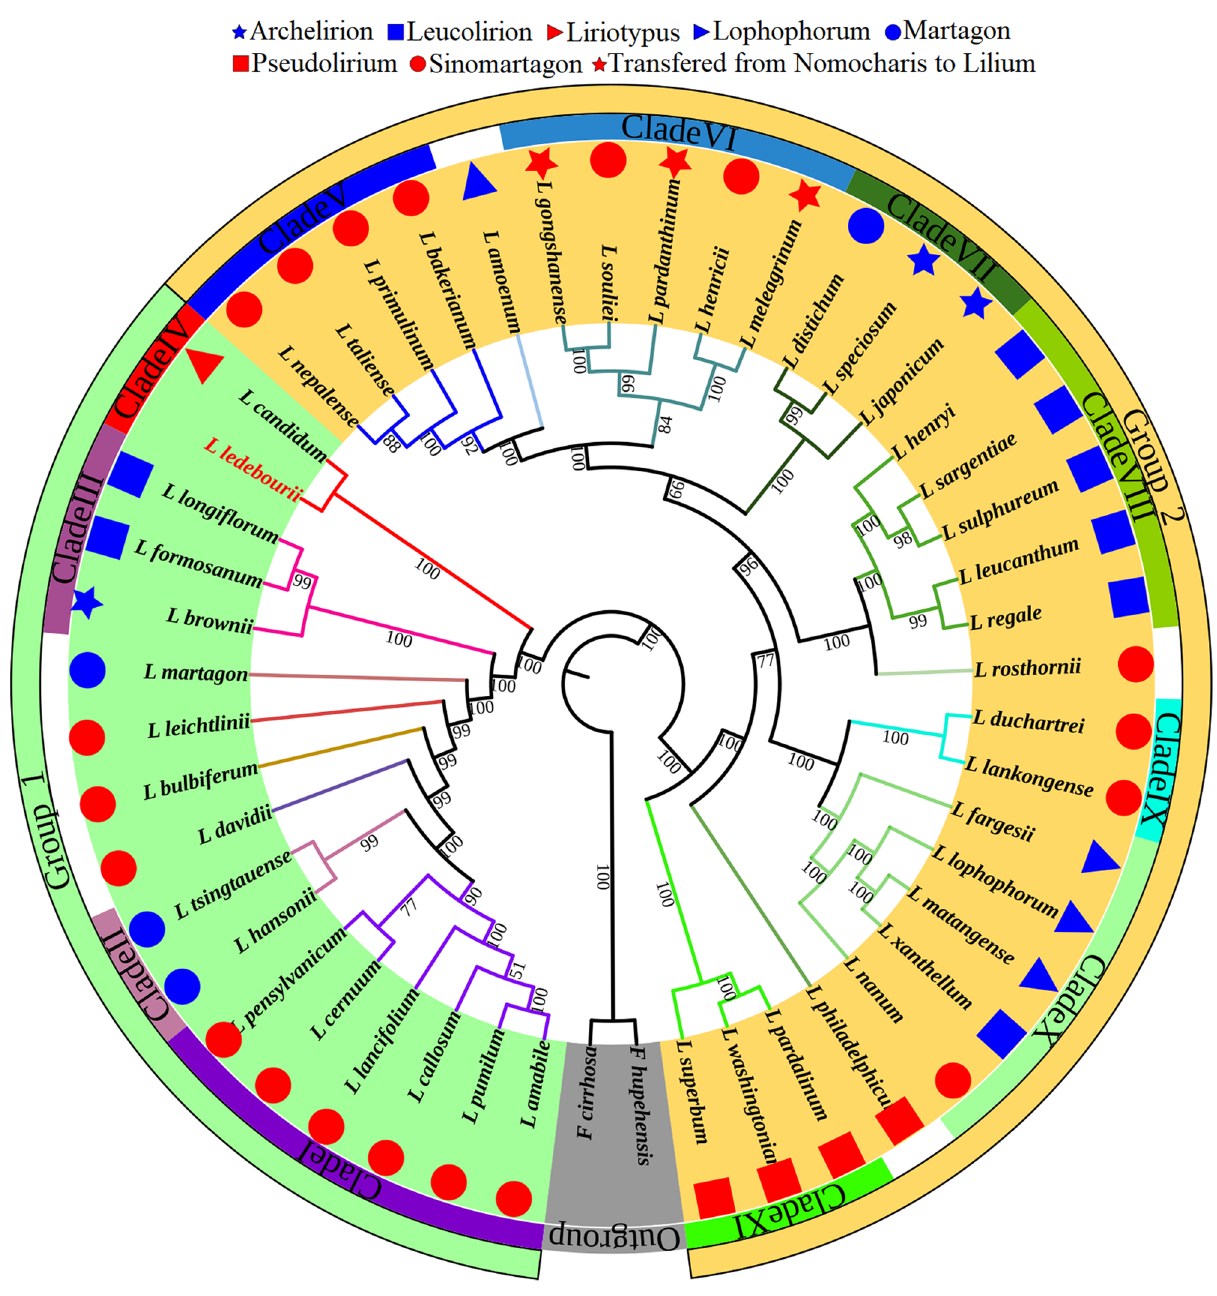
likelihood (ML). The ML bootstrap values are represented by the numbers above the